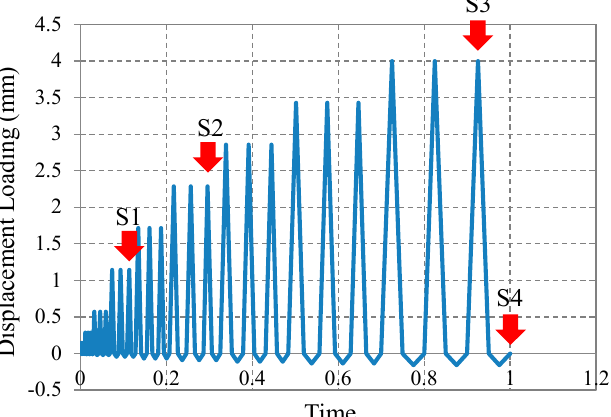
Figure 9. Displacement loading history.